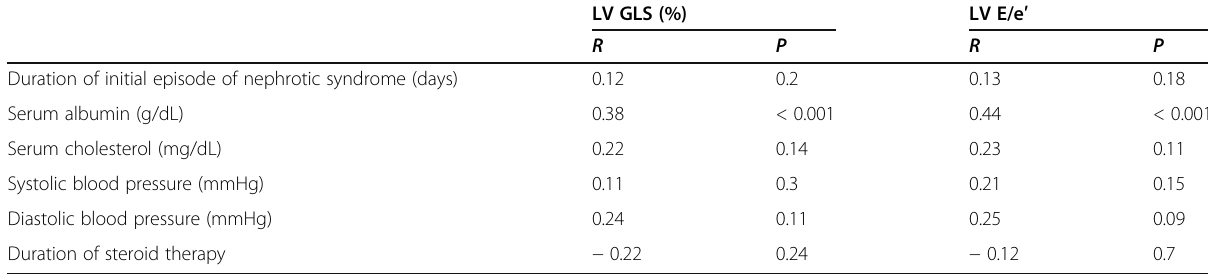
Table 5 Multivariate analysis for the predictors of systolic and diastolic function of LV in nephrotic